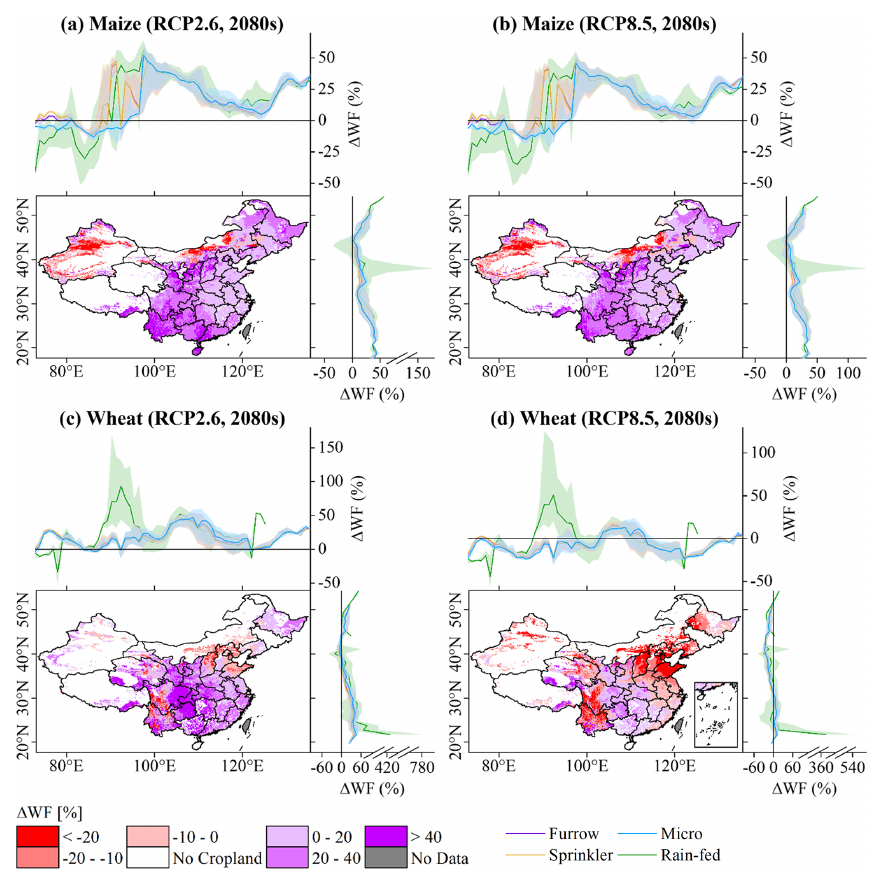
Figure 6. Spatial distributions in relative changes (cid:49) (%) in the WF (bottom left of each panel) by longitude (top of each panel) and latitude (right of each panel) under different irrigation regimes applied to both crops (wheat and maize) under two scenarios (RCP2.6 and RCP8.5) from 2013 to the